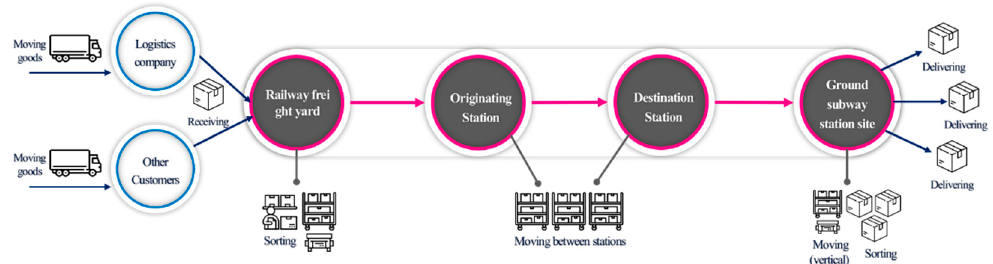
Figure 2. Process of underground logistics system.